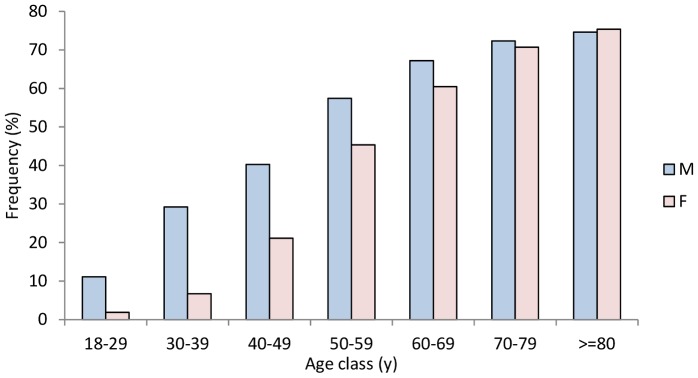
Overall age- and sex-specific prevalence of hypertension, Ogliastra, 2002–2008.